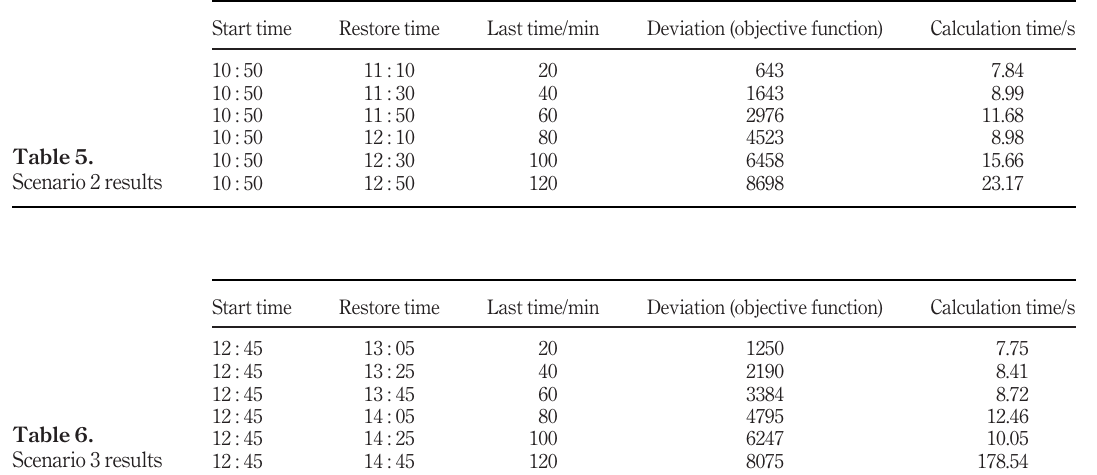
Table 6. Scenario 3